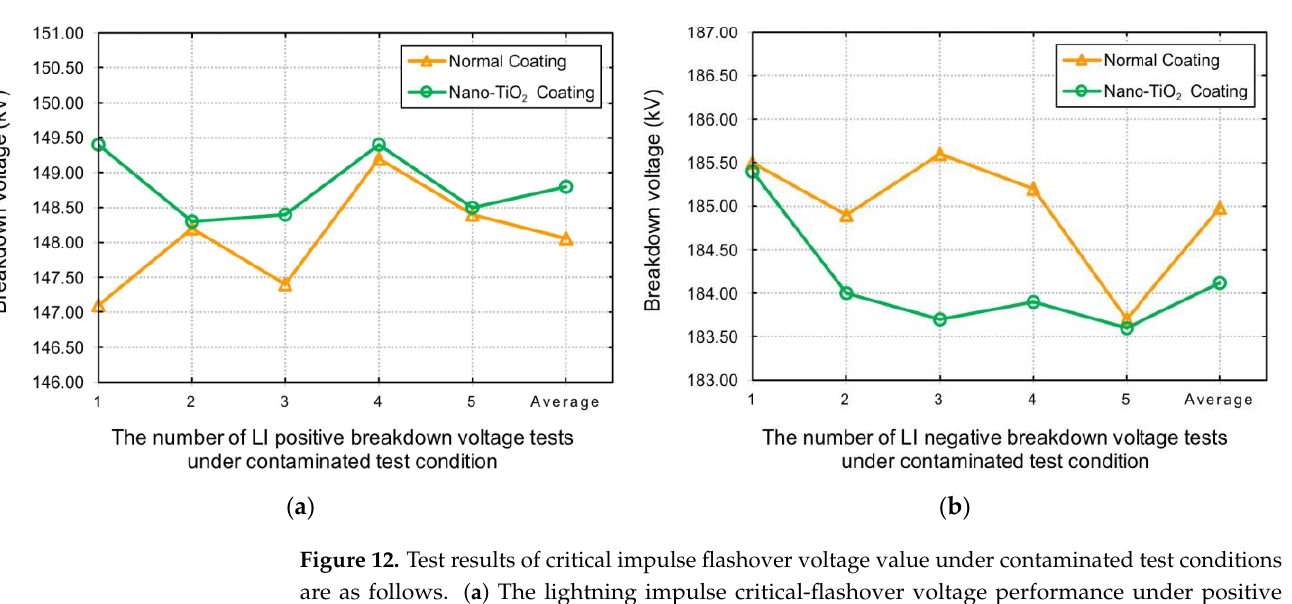
Figure 11. Test results of critical impulse flashover voltage value under normal test conditions are as follows. ( a ) The lightning impulse critical-flashover voltage performance under positive polarity testing; ( b ) The lightning impulse critical-flashover voltage performance under negative polarity testing.